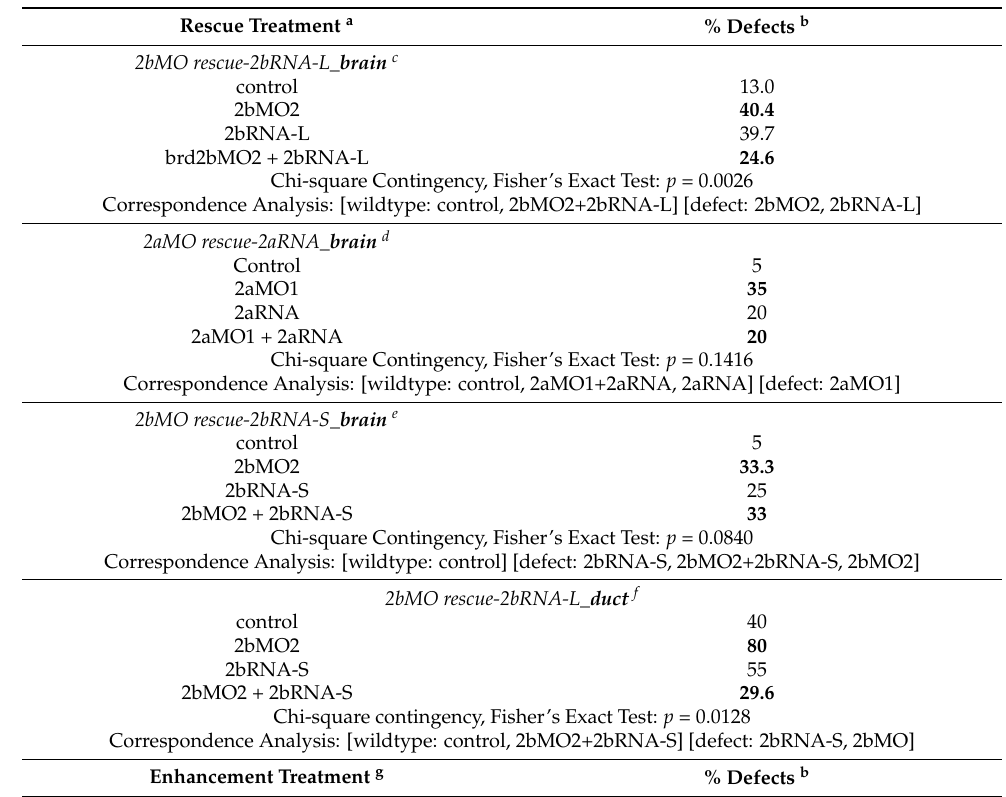
Table 2. Population morphology data: Brd2a-Brd2b rescue-enhancement